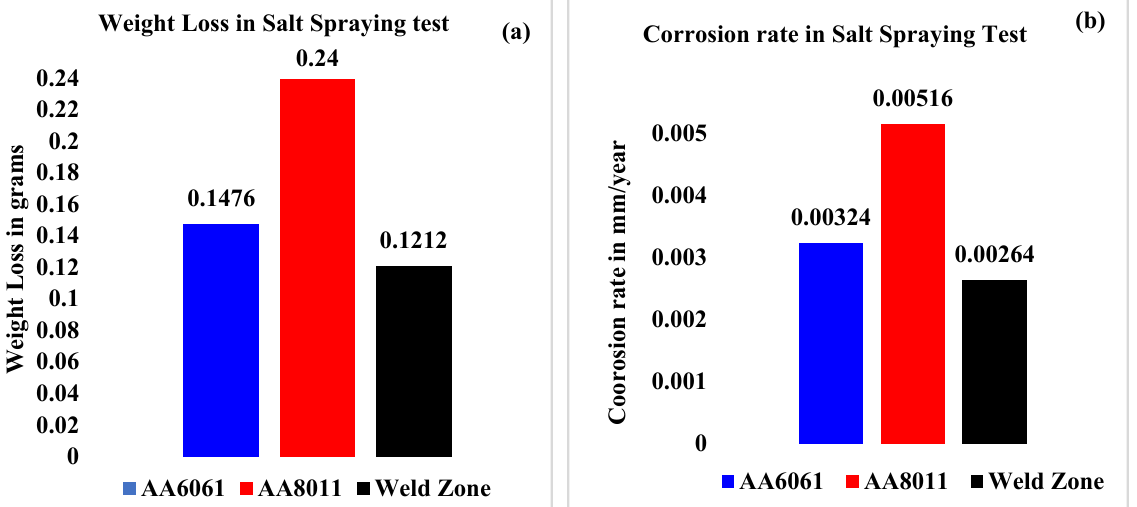
Table 6. Summary of the submersion test.